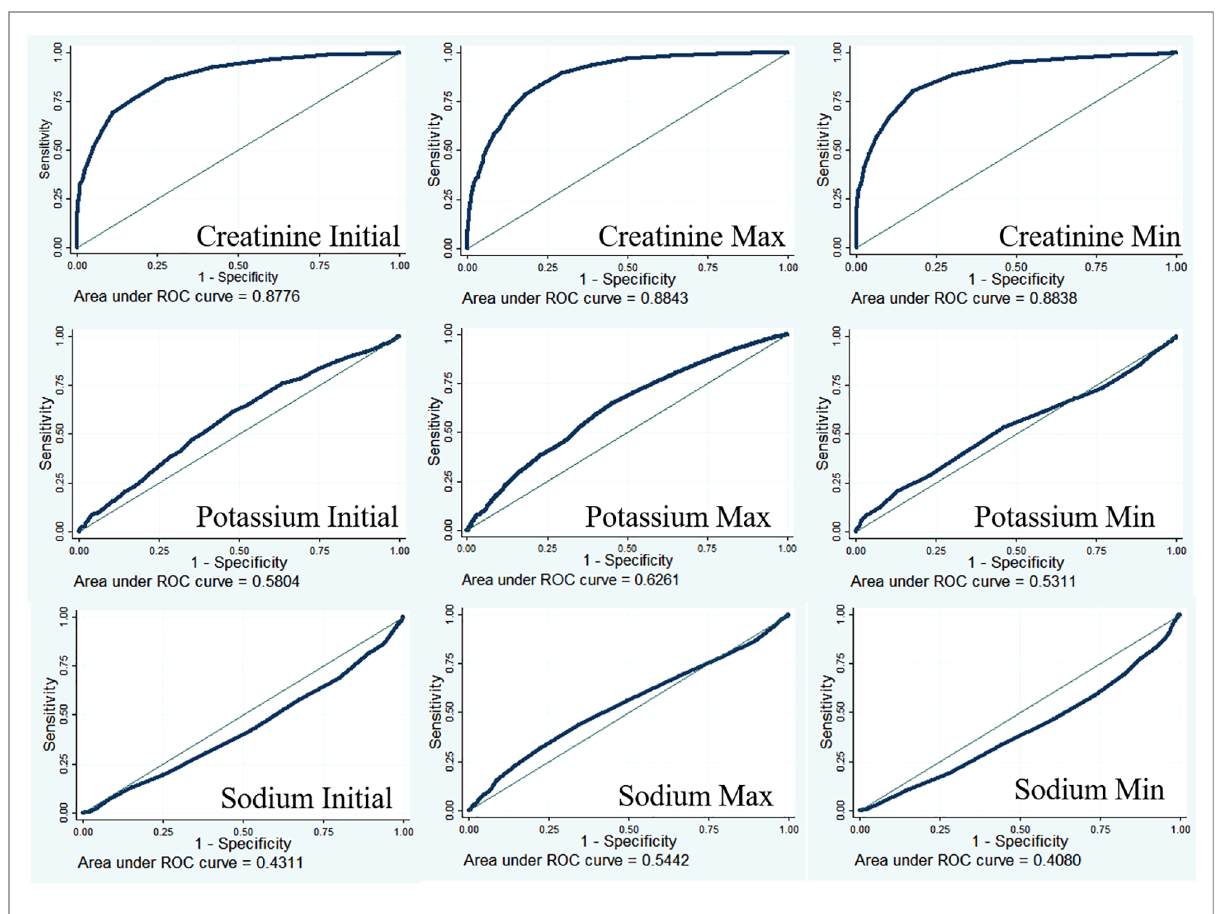
FIGURE 2 Receiver operating characteristic curves for creatinine, potassium, and sodium in